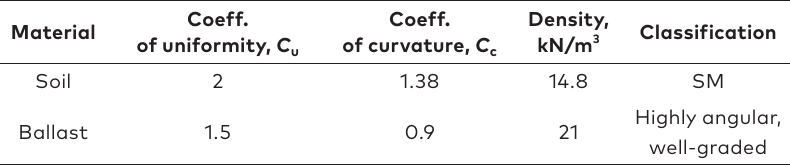
Table 1. Engineering parameters of material used in the study